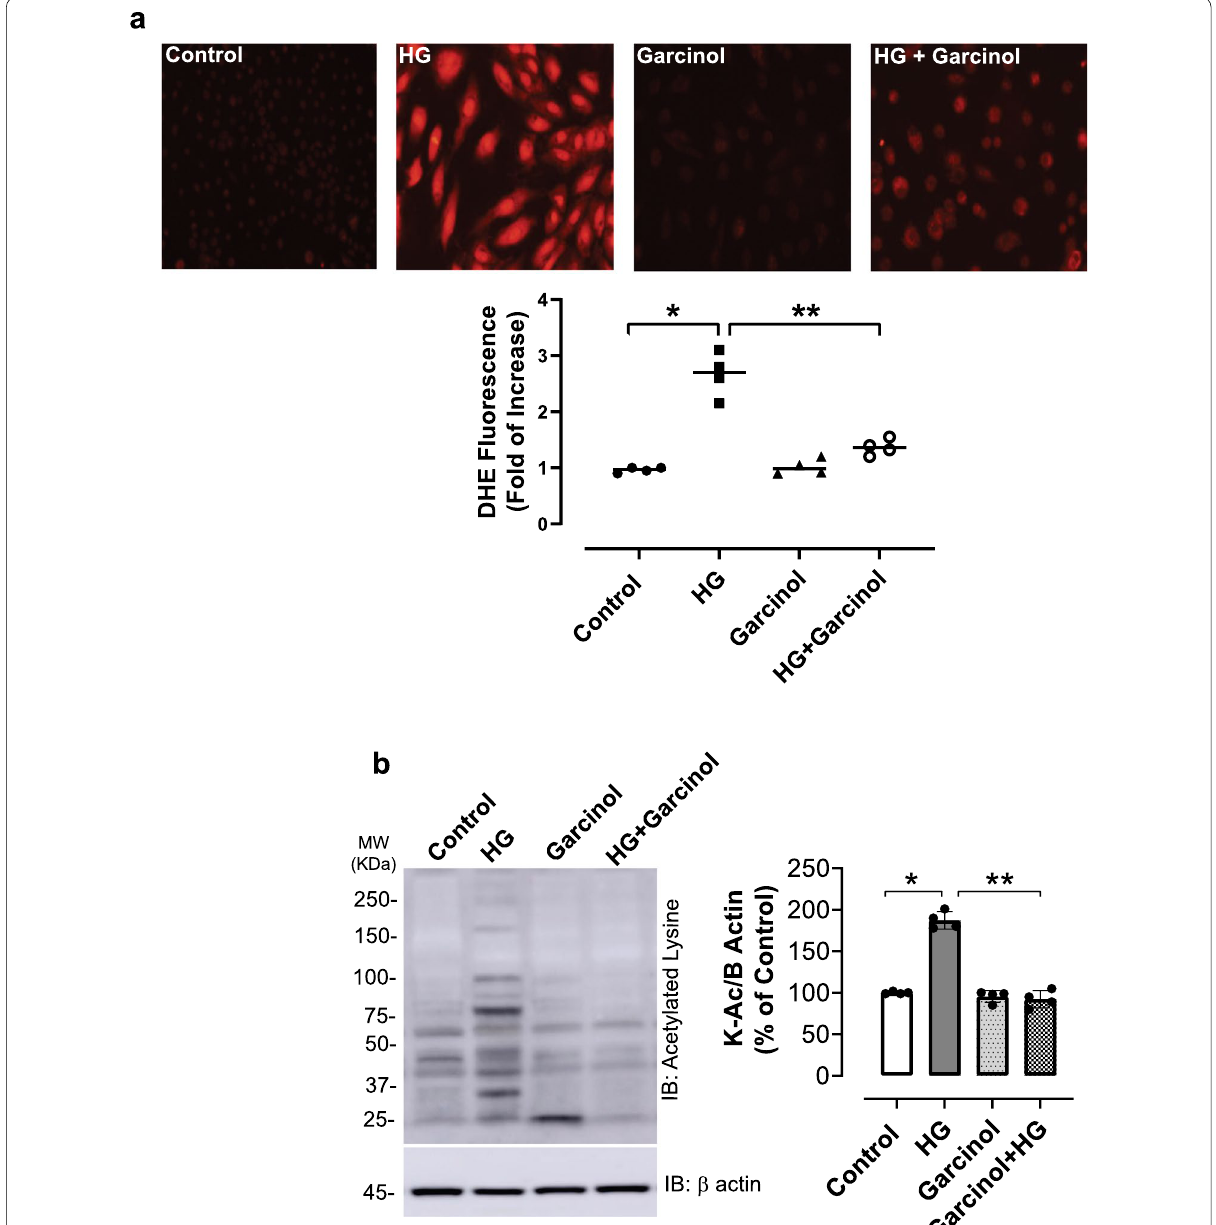
Fig. 7 Garcinol reduces HG‑induced ROS production in hVSMC. Quiescent hVSMC were pretreated with 15 µM garcinol, followed by stimulation with 25 mM HG or 5 mM NG for 60 min. a ROS production was detected using DHE staining. Representative photomicrographs depicting DHE fluorescence in each experimental group. Quantification of DHE staining was determined through fluorescent intensity in each cell by pixel intensity of the cell. b Global lysine acetylation was detected by western blot. β actin used as internal control. Results represent means per group, *p < 0.05 vs. controls, **p < 0.05 vs. HG